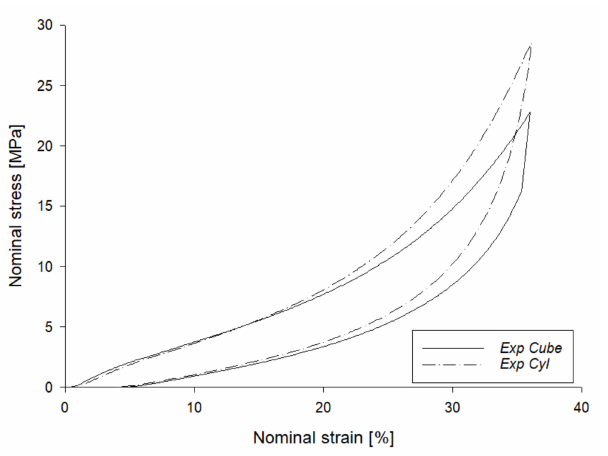
Figure 5. Compression-release tests on cubic and cylindrical TPU FDM